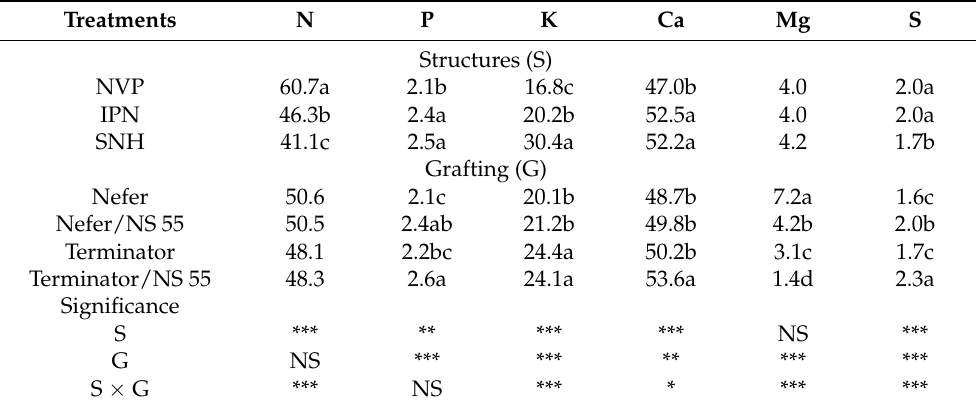
Table 7. Effect of structures and graft combinations on accumulation macroelements in leaves (g kg − 1 dry weight; DW).